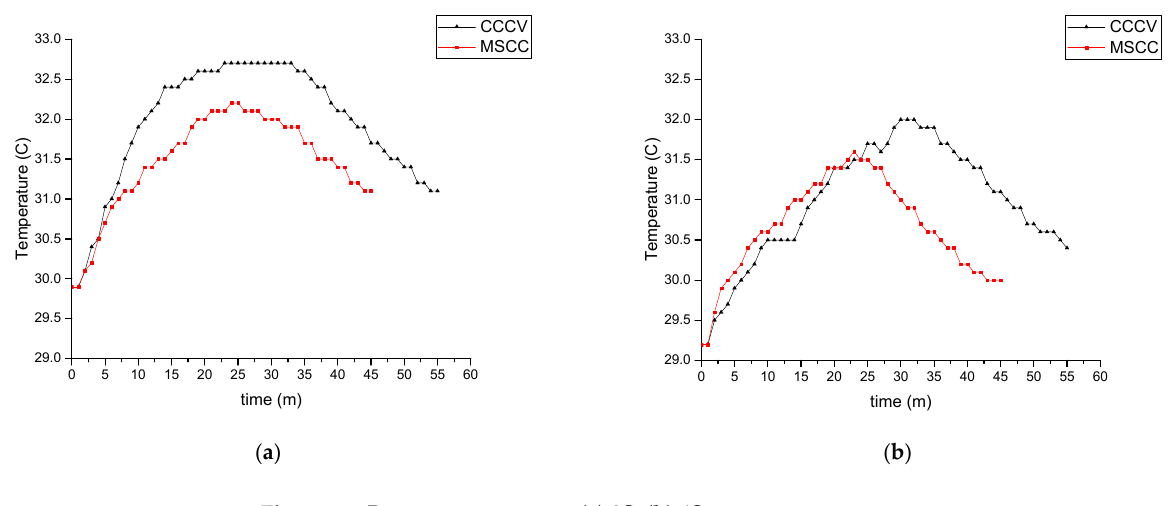
Figure 12. Charging current: ( a ) 2S; ( b ) 4S.